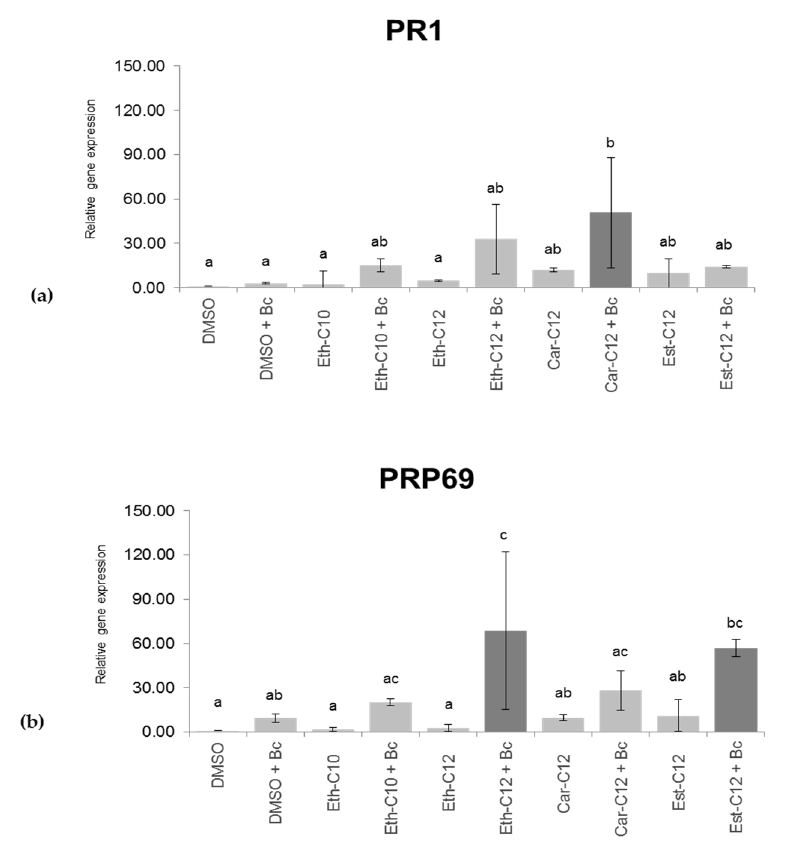
Figure 8. Relative defense gene expression in detached tomato leaves treated with only smRLs (300 µ M) or smRLs (300 µ M) and B. cinerea (Bc) 3 days post-elicitation, 48 h after infection with the pathogen. ( a ) Expression level of PR1 ; ( b ) Expression level of PRP69 . Di ff erent lower-case letters indicate significant di ff erences among the means as determined by an ANOVA followed by the Tukey-HSD post-hoc test ( p ≤ 0.05). Fold expression values are normalized against tomato EF1 α and Actin genes as controls and DMSO 0.1% as a reference